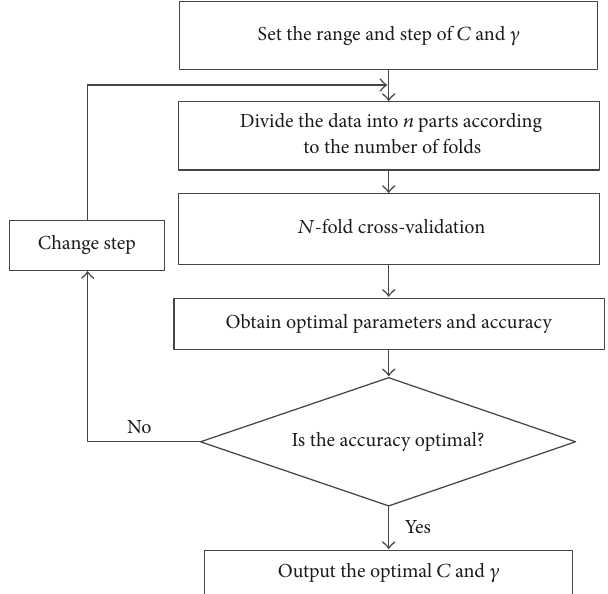
Figure 2: Flow chart of Grid